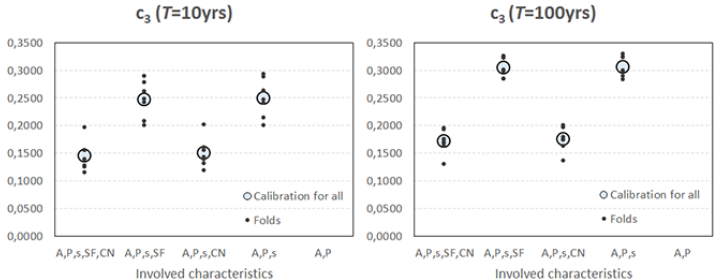
Figure 23. Values of parameter c 3 calibrated to the whole data set and to 7 folds for N = 10 years (left panel) and N = 100 years (right panel).